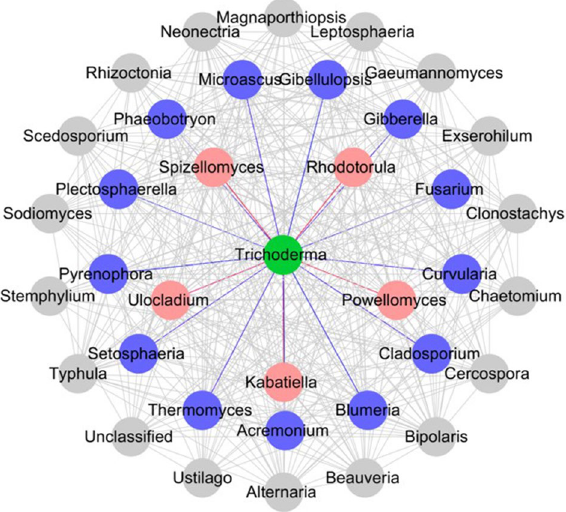
Figure 5. Network diagram of linear relationship between Trichoderma and plant pathogens. The red mark represented a positive correlation, and the blue was negative ( p < 0.05).